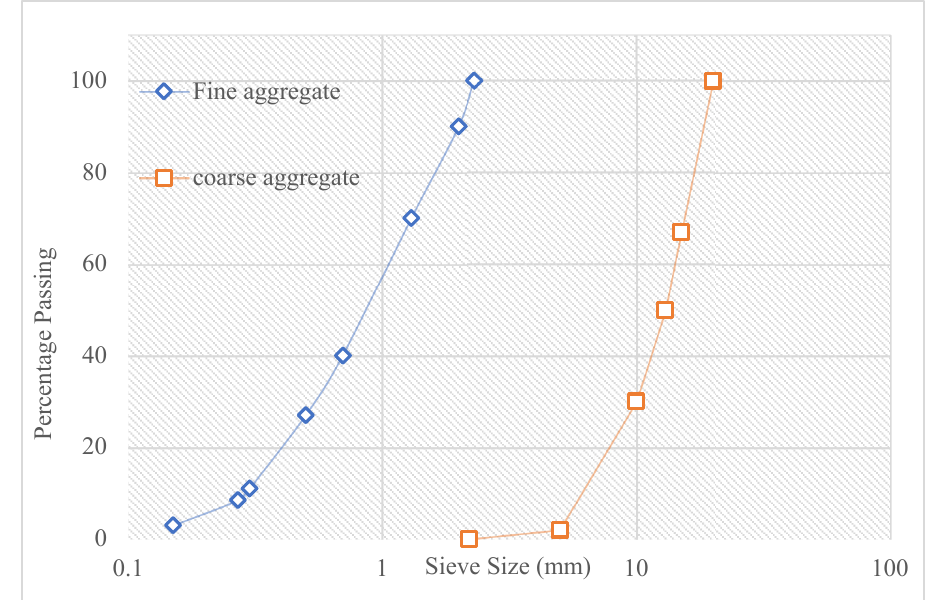
Figure 1. Distribution of particle-size of the coarse and fine aggregates.